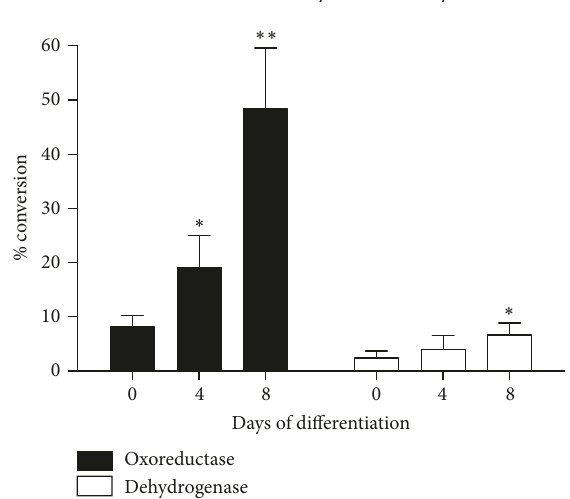
Figure 3: Bidirectional oxoreductase (conversion of cortisone to active cortisol, black bars) and dehydrogenase (conversion of cortisol to inactive cortisone, open bars) activity of the 11 𝛽 -HSD1 enzyme in 3T3-L1 adipocytes. Cells were grown to confluence and differentiated into adipocytes by day 8 of the treatment. Cells were incubated in DMEM containing cortisone or cortisol (1 𝜇 M) for 20min and the respective metabolites/conversion ratios were measured by LC-MS. Data are the mean ± SEM ( 𝑛 = 3 ). ∗ 𝑝 < 0.05 and ∗∗ 𝑝 < 0.01 versus vehicle by Dunnett’s test subsequent to one- way